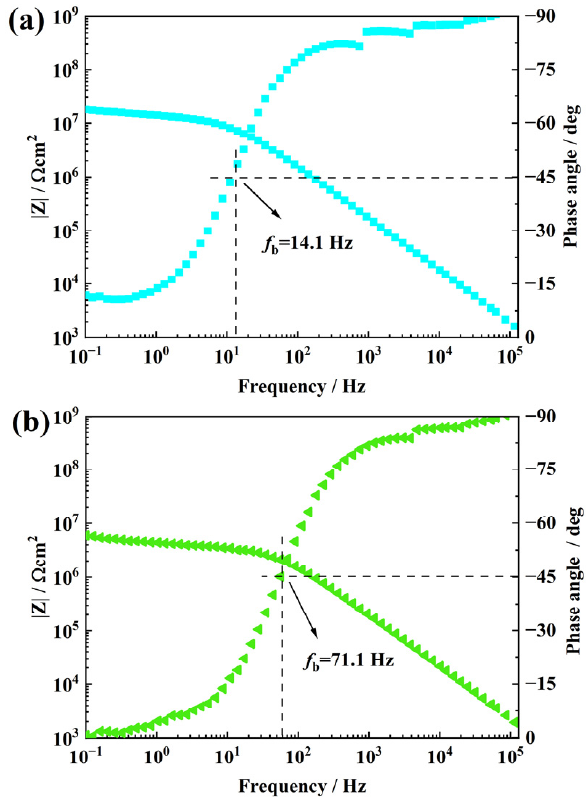
Figure 7. Bode plots of RTV nanocomposite coatings, respectively, filled with 0.3 wt.% ( a ) and 0.5 wt.% ( b ) f-GO nanosheets after NO 2 oxidation.